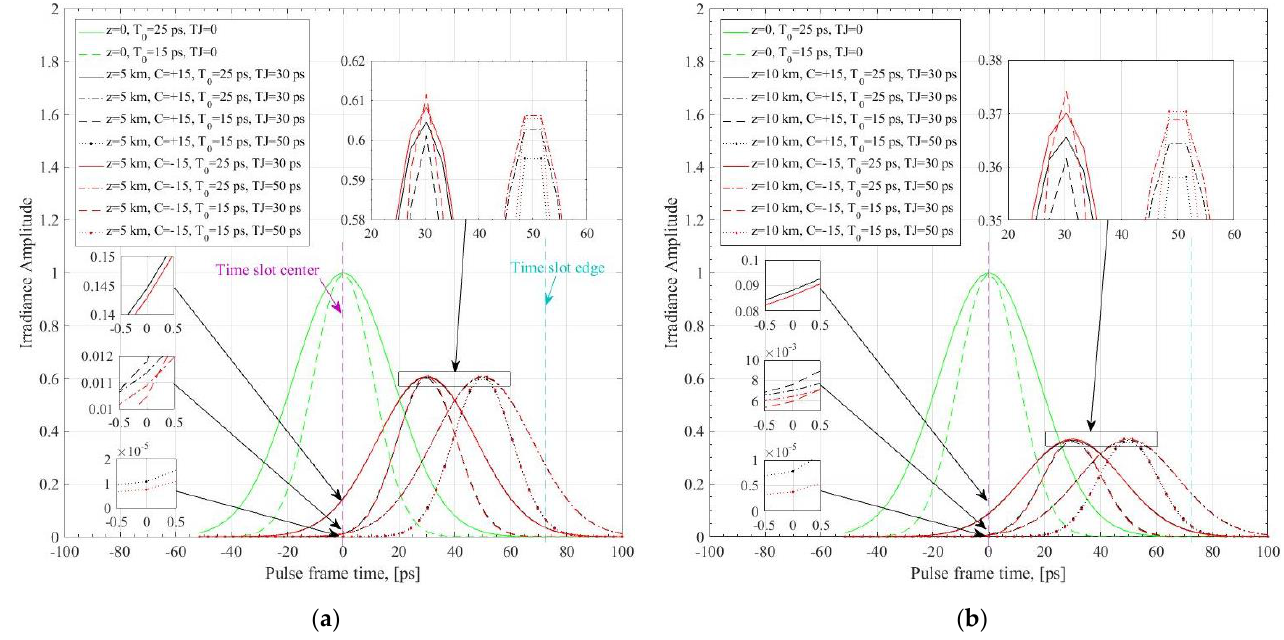
Figure 1. Irradiance amplitude profiles of some characteristic pulses within a time slot range with power losses ( l = 0.1 km −1 ) and various original pulsewidths, TJ strength parameters, and opposite chirp values for an FSO link of ( a ) z = 5 km and ( b ) z = 10 km. The time slot edge indicated at the time instant of 71.4 ps corresponds to 7 Gbps.